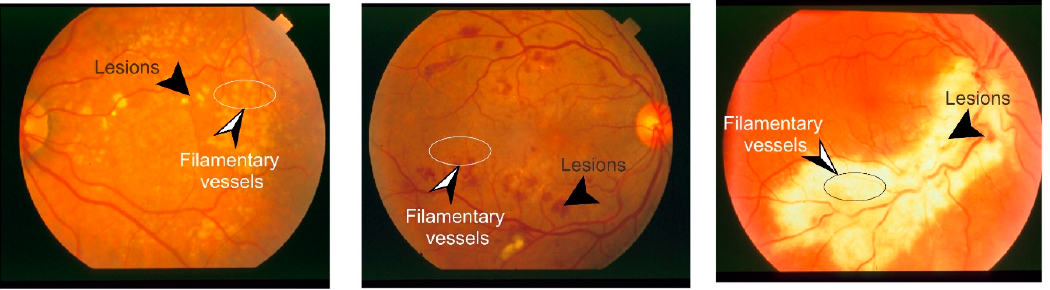
Figure 6. Effect of retinal lesions on filamentary vessel structures appearance.